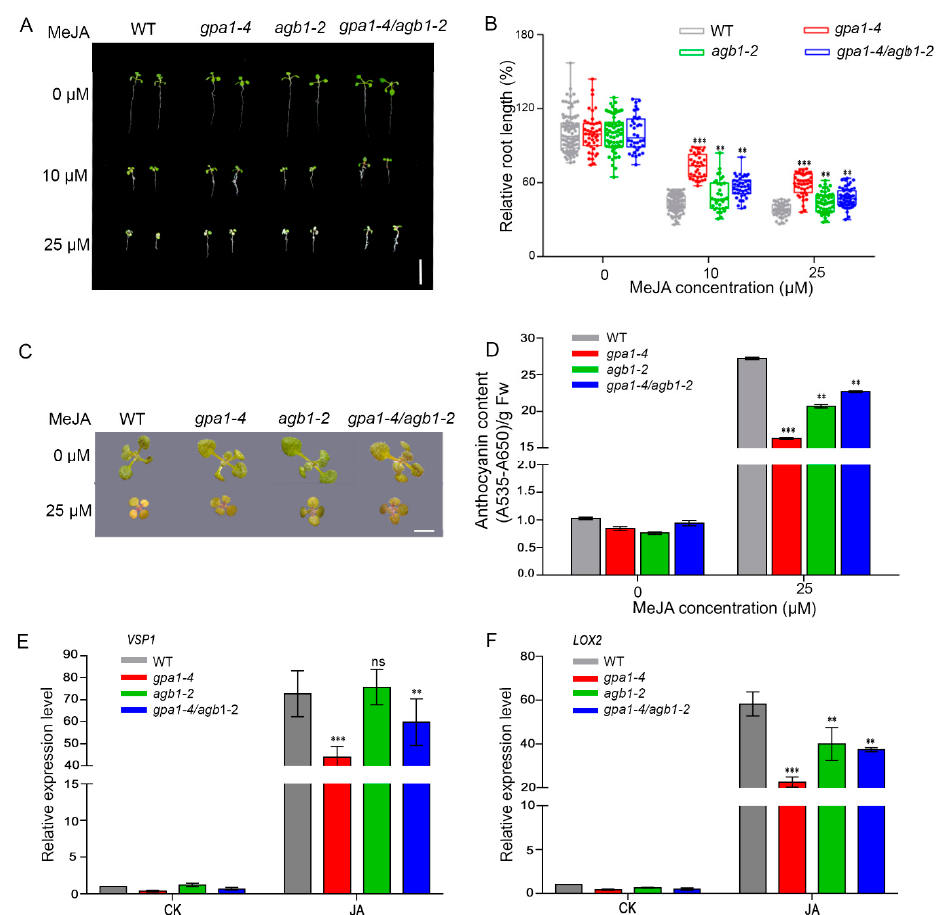
Figure 1. The heterotrimeric G protein complex is involved in JA signaling. ( A ) Root phenotypes of 9-day-old seedlings of WT, gpa1-4 , agb1-2 , and gpa1-4 / agb1-2 grown on MS medium containing indicated concentrations of MeJA. Bar = 1 cm. ( B ) Relative root length of 9-day-old seedlings of WT, gpa1-4 , agb1-2 , and gpa1-4 / agb1-2 grown on MS medium containing indicated concentrations of MeJA. Data shown are from 34 to 104 plants. Significant di ff erences are denoted by asterisks (** p < 0.01, *** p < 0.001, Student’s t test). ( C ) Phenotype of 11-day-old seedlings of WT, gpa1-4 , agb1-2 , and gpa1-4 / agb1-2 grown on MS medium containing indicated concentrations of MeJA. Bar = 1 cm. ( D ) Anthocyanin contents of 11-day-old seedlings of WT, gpa1-4 , agb1-2 , and gpa1-4 / agb1-2 grown on MS medium containing indicated concentrations of MeJA. Error bars represent SD ( n = 3). Significant di ff erences are denoted by asterisks (** p < 0.01, *** p < 0.001, Student’s t test). ( E , F ), Relative expression level of VSP1 ( E ) and LOX2 ( F ) in WT, gpa1-4 , agb1-2 , and gpa1-4 / agb1-2 seedlings treated without (CK) or with 100 µ m MeJA for 8 h. Error bars represent SD ( n = 3). Significant di ff erences are denoted by asterisks (** p < 0.01, *** p < 0.001, ns, no significant di ff erence, Student’s t